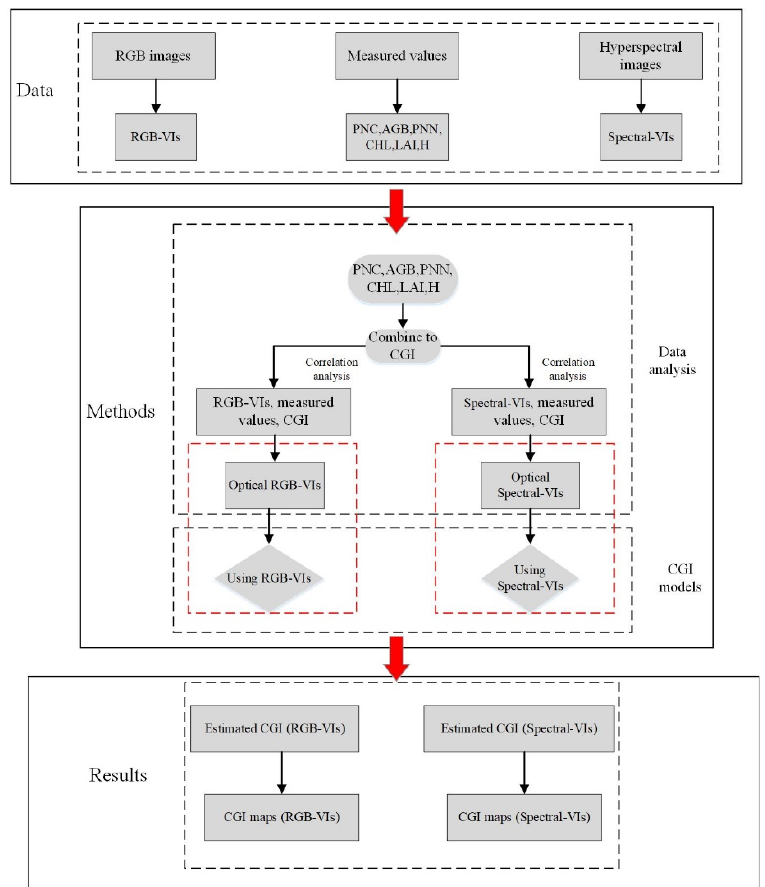
Figure 2. Flowchart showing data processing.